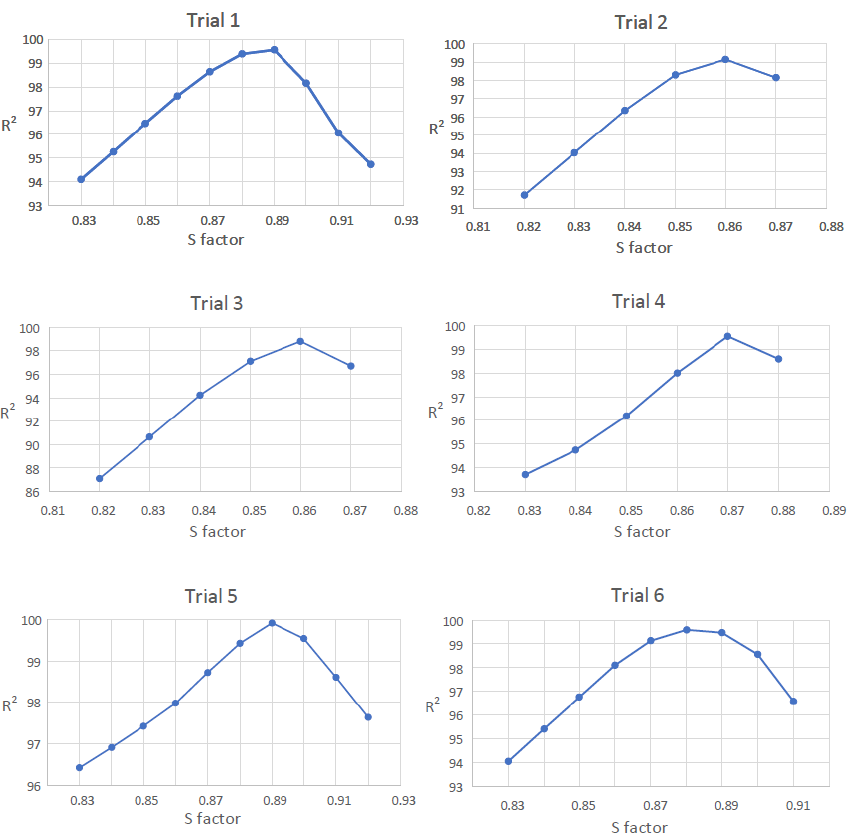
Figure 7. Evolution of model fit as a function of S factorR for the 6 patients. The number of points detected for each optimal S found has been compared with the number of points identified manually (obtained as an average of the manual count performed by five different evaluators under the same lighting conditions), the results of which are shown in Table